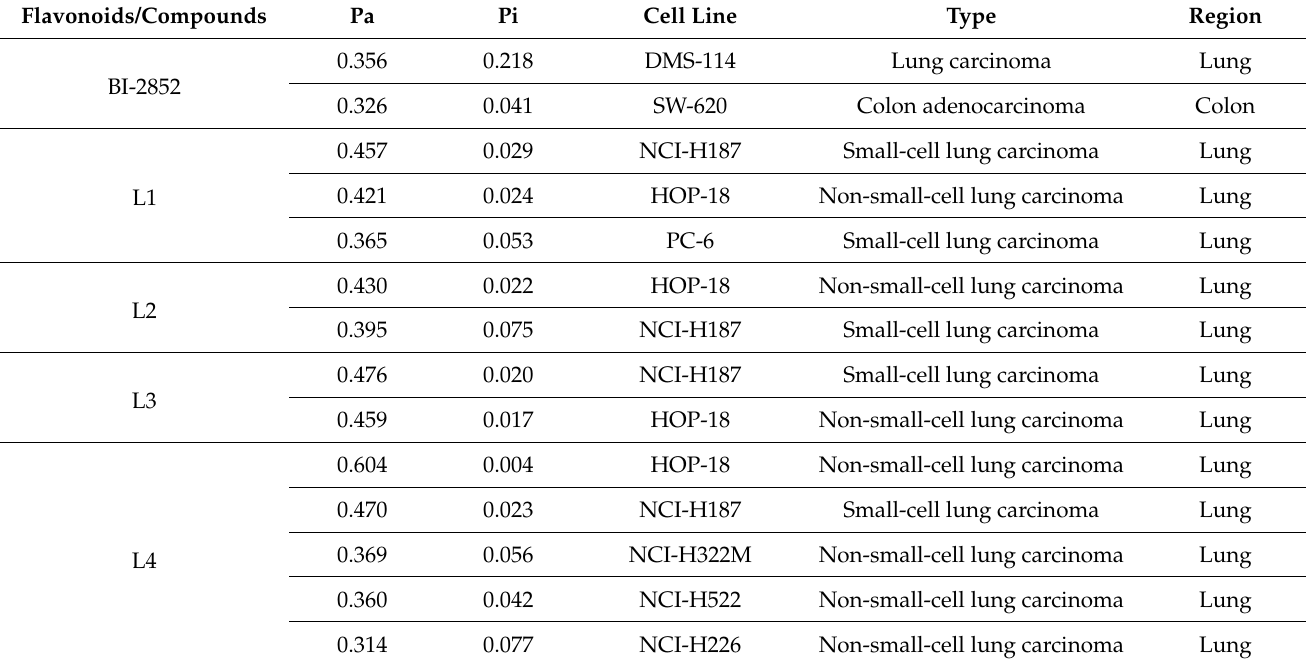
Figure 8. Molecular targets of top four lead flavonoids: the pie chart represents the predicted molecu- lar targets such as kinase, cytosolic protein, lyase, oxidoreductase, protease, phosphatase, epigenetic erasers, cytochrome p450, GPCR (family A and B), nuclear receptor, ion channels, phosphodiesterase and membrane proteins of 5-Dehydroxyparatocarpin K ( A ), Carpachromene ( B ), Sanggenone H ( C ), and Kuwanol C ( D ). Table 7. Cancer-cell-line cytotoxicity prediction of top 4 lead